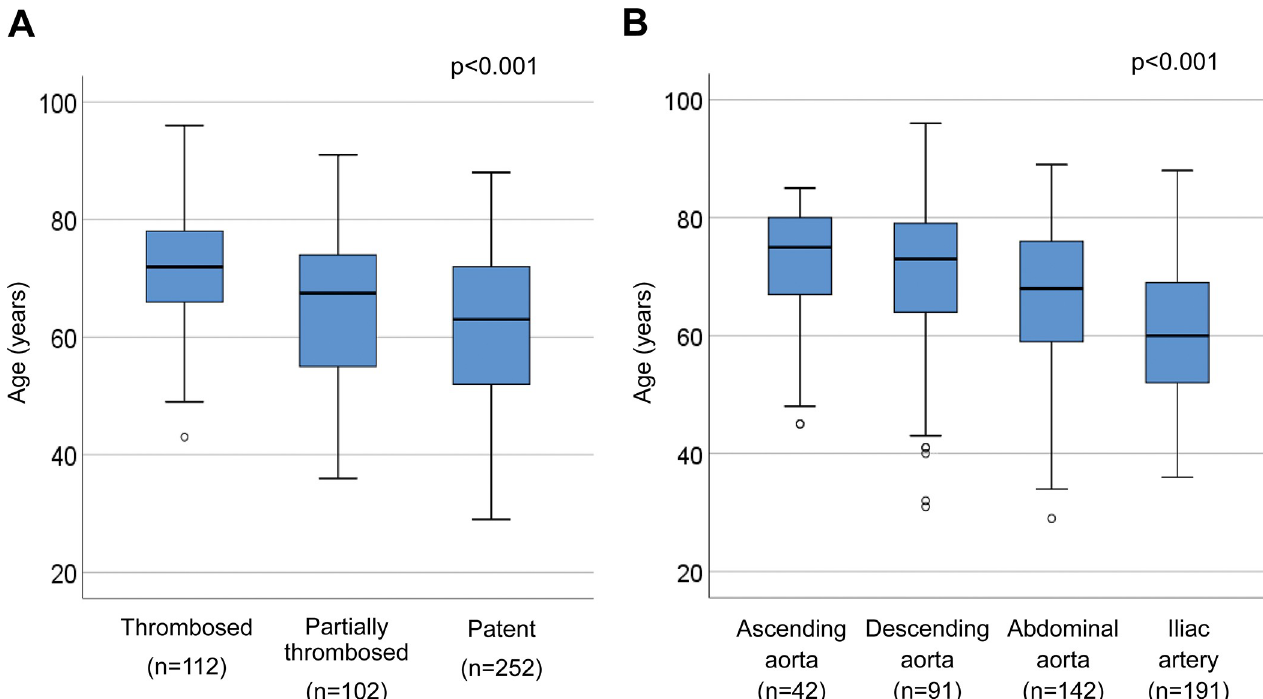
Fig 3. Box and whisker plots of morphologic classifications in relation to age. (A) False lumen status. (B) Extent of aortic dissection. Probability values were obtained by Kruskal-Wallis test.